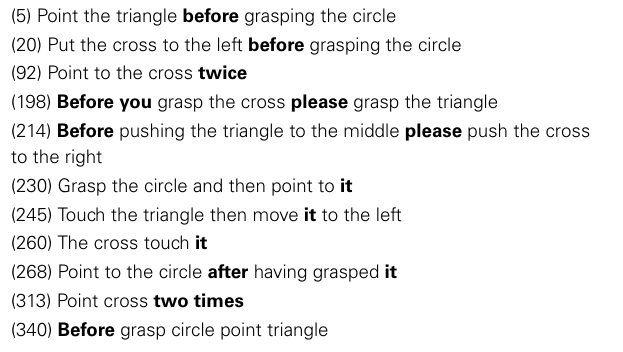
Table 6 | Generalization errors. Table 7 | Example sentences produced by naïve subjects (of the 373 corpus; see SM4.2), and understood by the model (i.e., 0% error in LoO generalization simulations for a reservoir of 1000